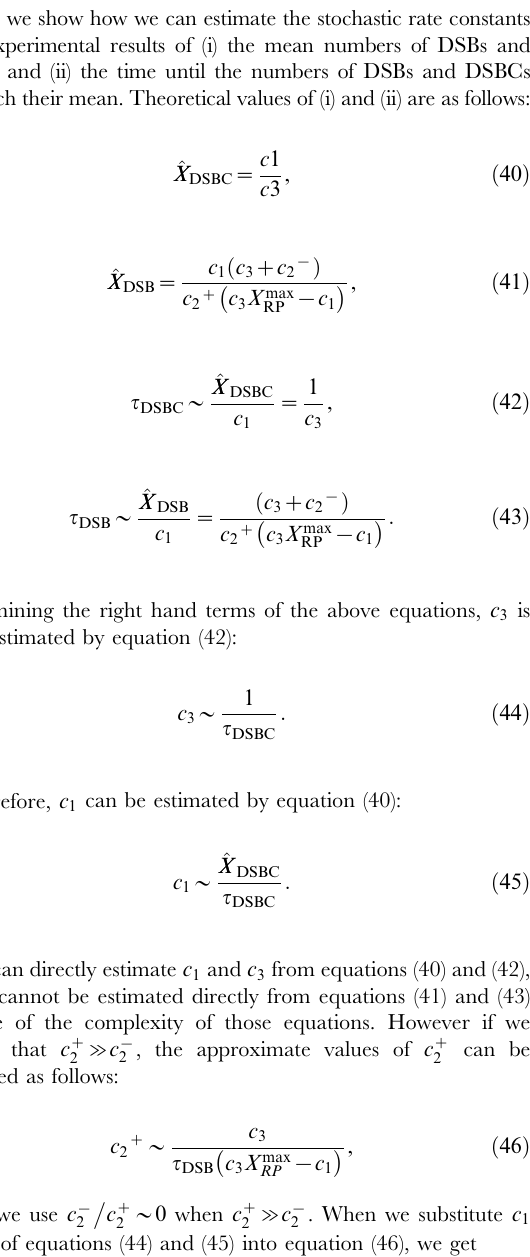
Figure 9 are as follows: k ATM3 ~ 0 : 1 , k p53 ~ 0 : 6 , j p53 ~ 1 : 9